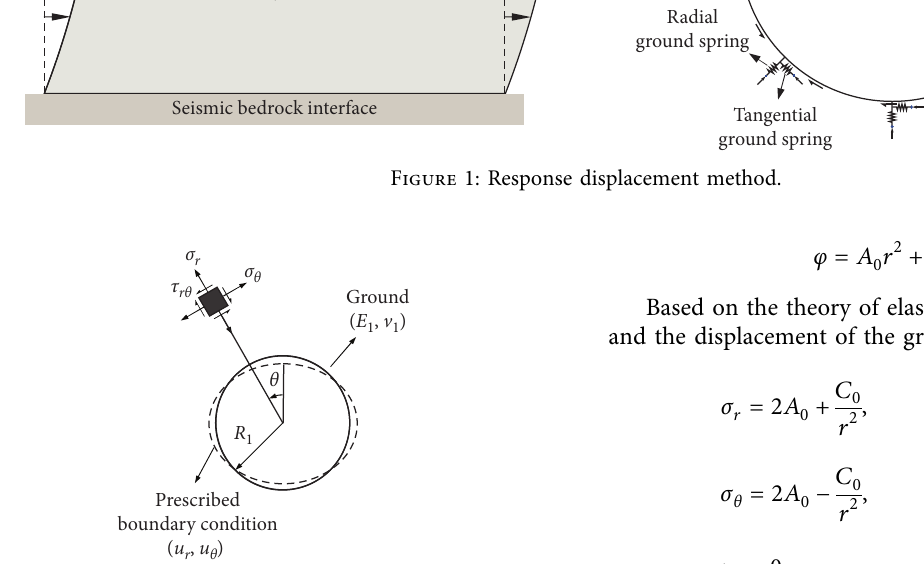
Figure 2: Analysis model to derive subgrade modulus. Table 1: Scenarios of ground deformation in the derivation. Deformation